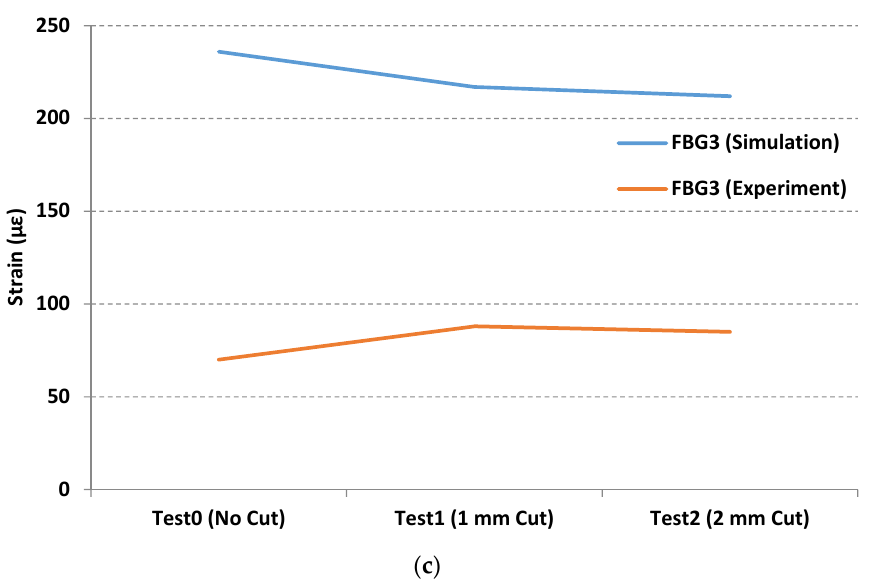
Figure 15. Comparison of maximum strain measurements between simulation and experimental tests for ( a ) Sensor FBG1; ( b ) Sensor FBG2 and ( c ) Sensor FBG3.